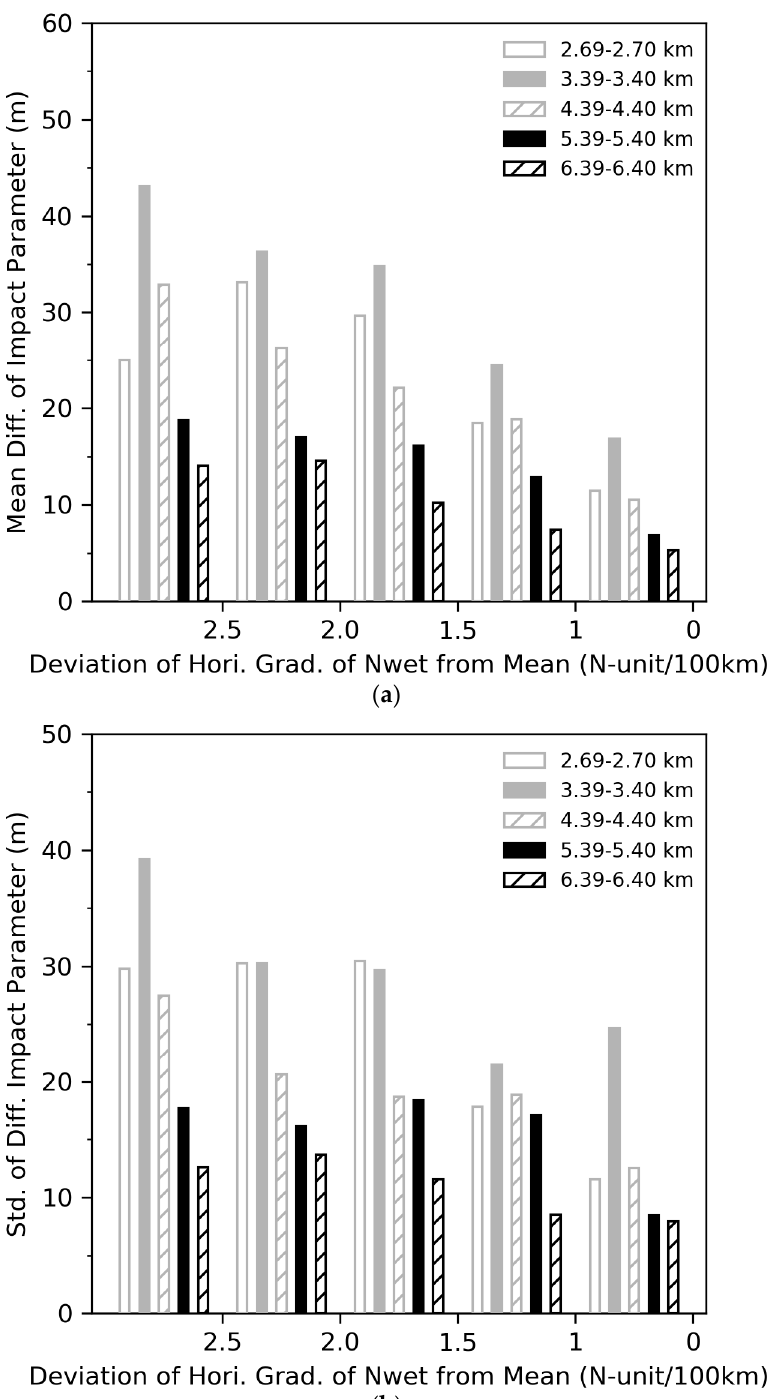
Figure 10. ( a ) Mean values and ( b ) standard deviations of the differences in impact parameter from the mean (see black curve in Figure 9c) normalized by the standard deviations (see the vertical line in Figure 9c) calculated at 50-km horizontal-distance intervals. We divided the differences into 5 groups: with impact heights at the perigee points between 2.69 and 2.70 km (gray hollow bars), between 3.39 and 3.40 km (gray solid bars), between 4.39 and 4.40 km (gray slashed bars), between 5.39 and 5.40 km (black solid bars), and between 6.39 and 6.40 km (black slashed